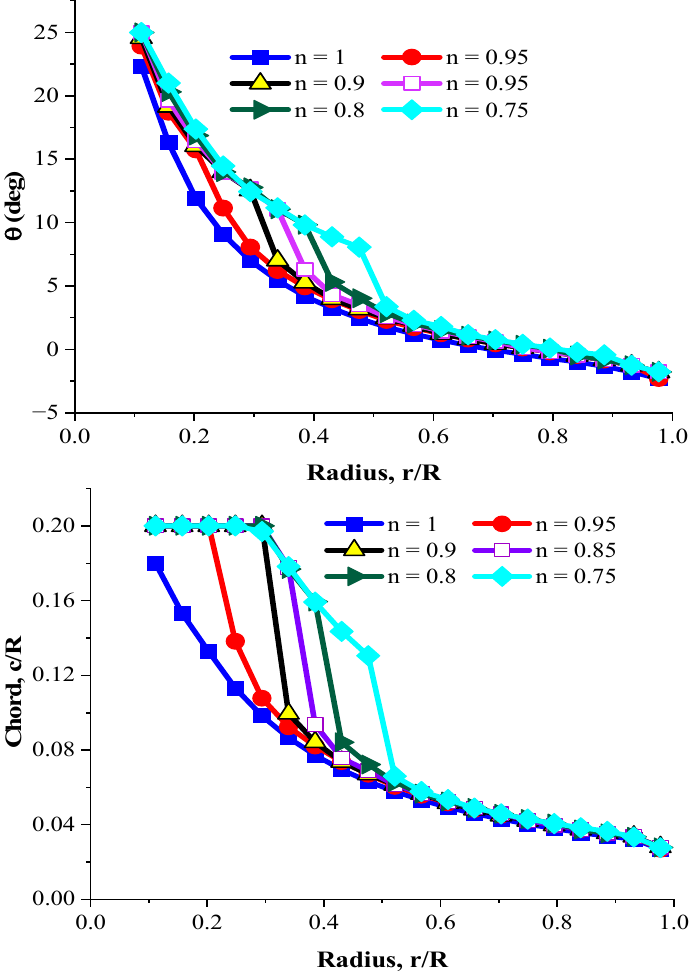
Figure 9. The θ and c profiles for the blades with different n values.